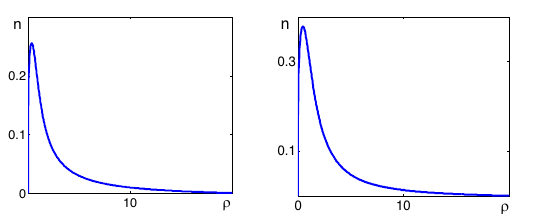
Fig. 4. Similar to Fig. 3, but calculations are completed with ka = 0.3